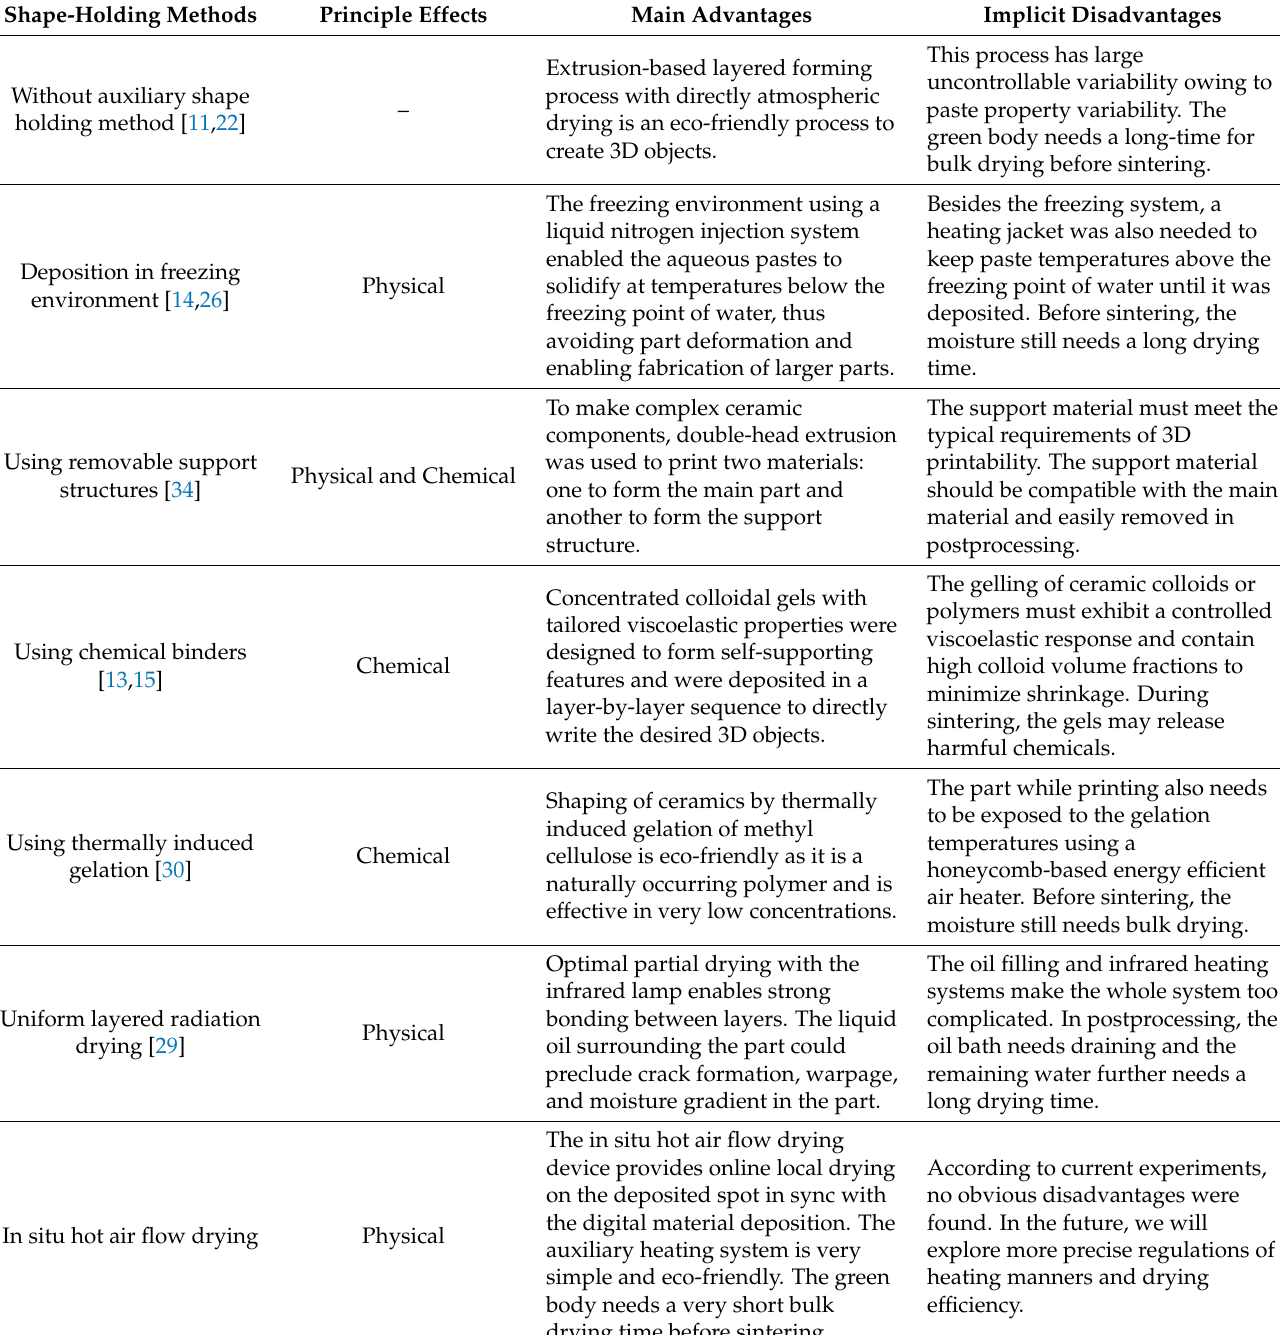
Table 2. Comparative analysis of different shape-holding